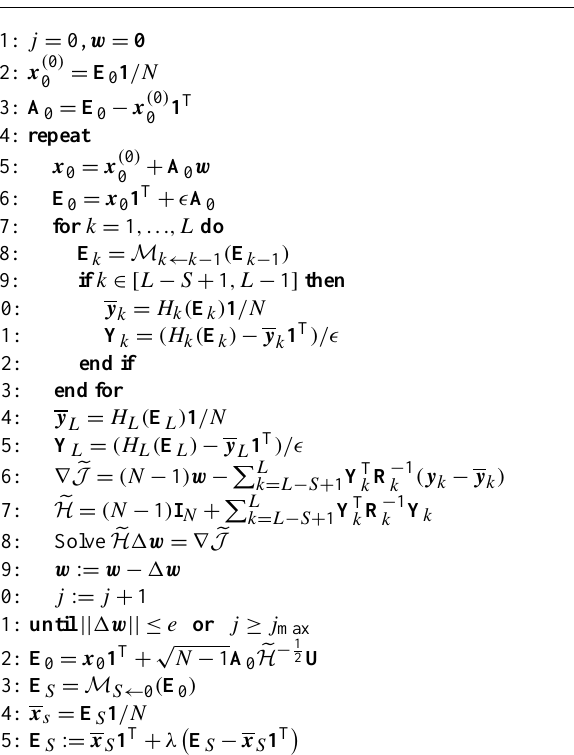
Algorithm 1 A cycle of the lag-L / shift-S / SDA / bundle / Gauss-Newton